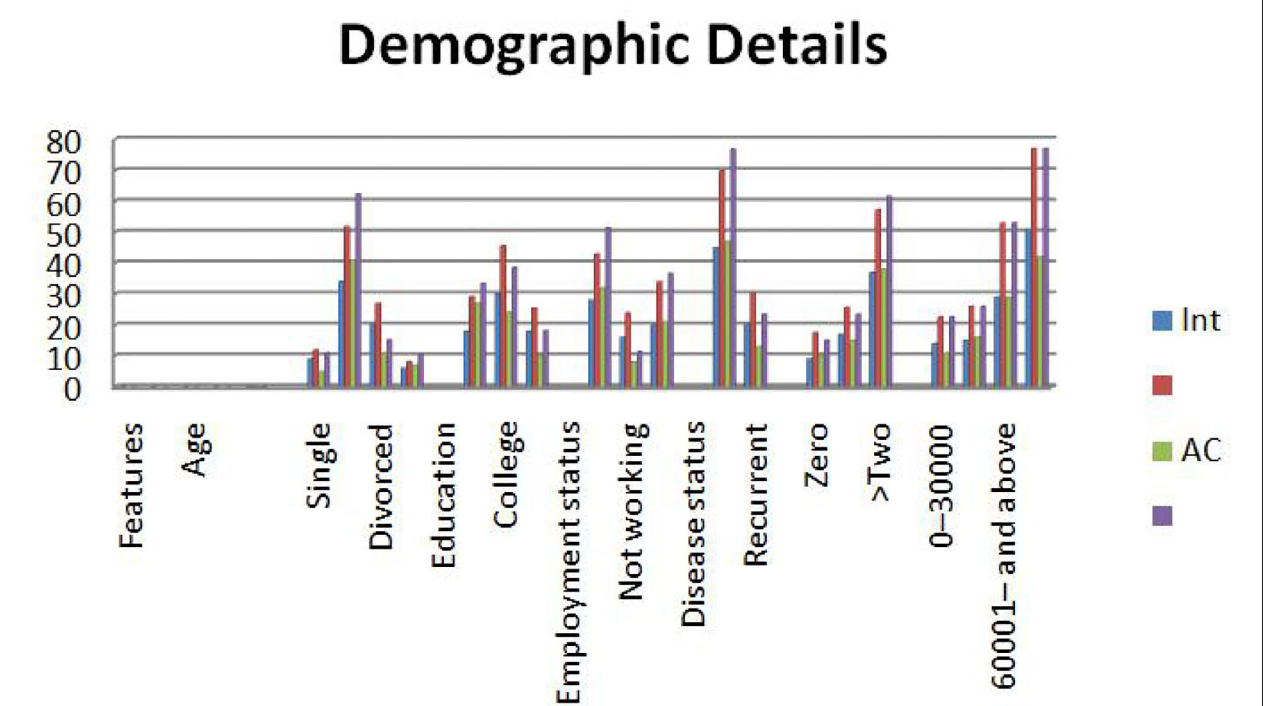
FIGURE 1 | Graphical representation of demographic details.